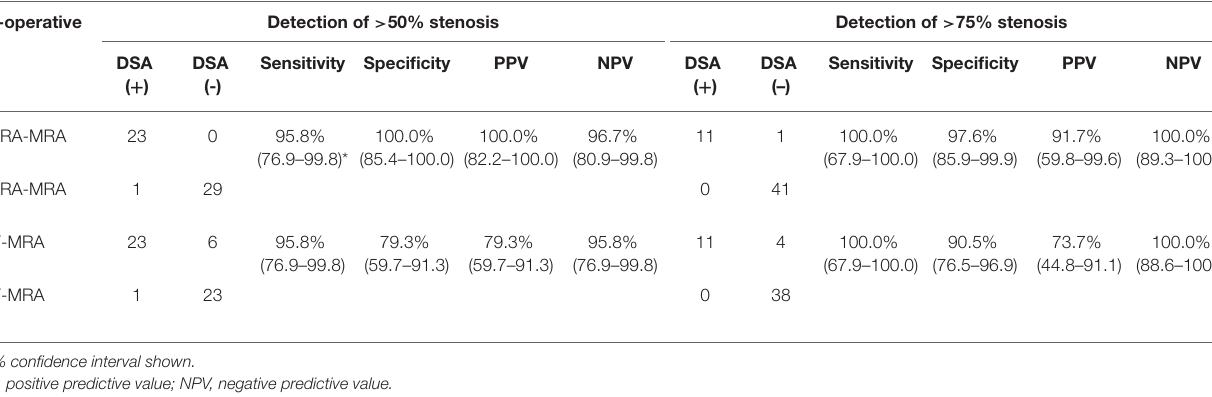
TABLE 2 | Evaluation of the diagnostic performance of PETRA-MRA and TOF-MRA for detecting stenosis > 50% and stenosis > 75% using DSA as reference for the pre-intervention evaluation. Pre-operative